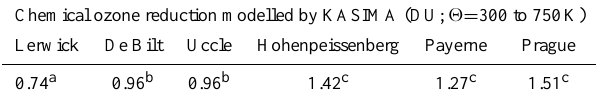
Table 7. Cumulated chemical ozone depletion as simulated by KASIMA; values given in